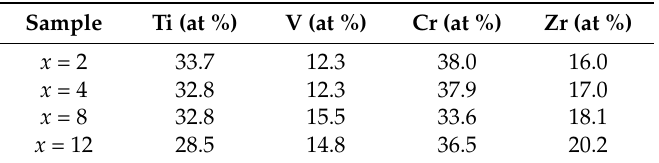
Table 4. EDX analysis showing the elemental composition of secondary phase 2 (point 3) of: Ti 1 V 0.9 Cr 1.1 + x wt % Zr alloys for x = 0, 2, 4, 8, and